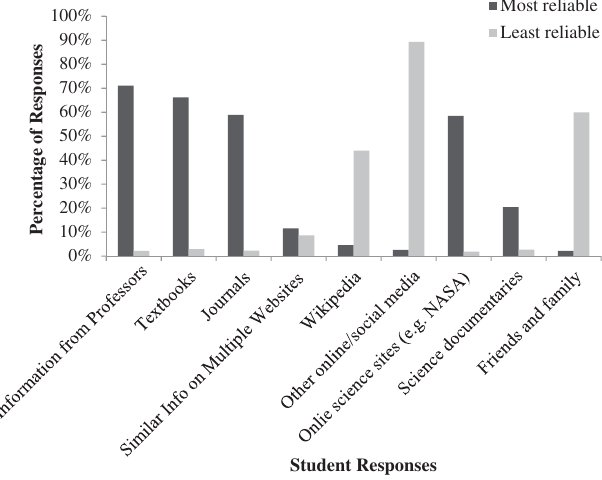
FIG. 7. Students ’ top choices about the most and least reliable sources of science